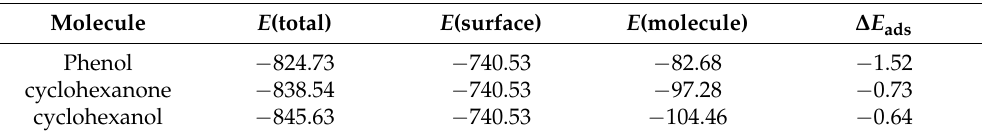
Table 2. The calculated phenol, cyclohexanone, cyclohexanol adsorption energy on Ru@N-CS system, unit: eV.